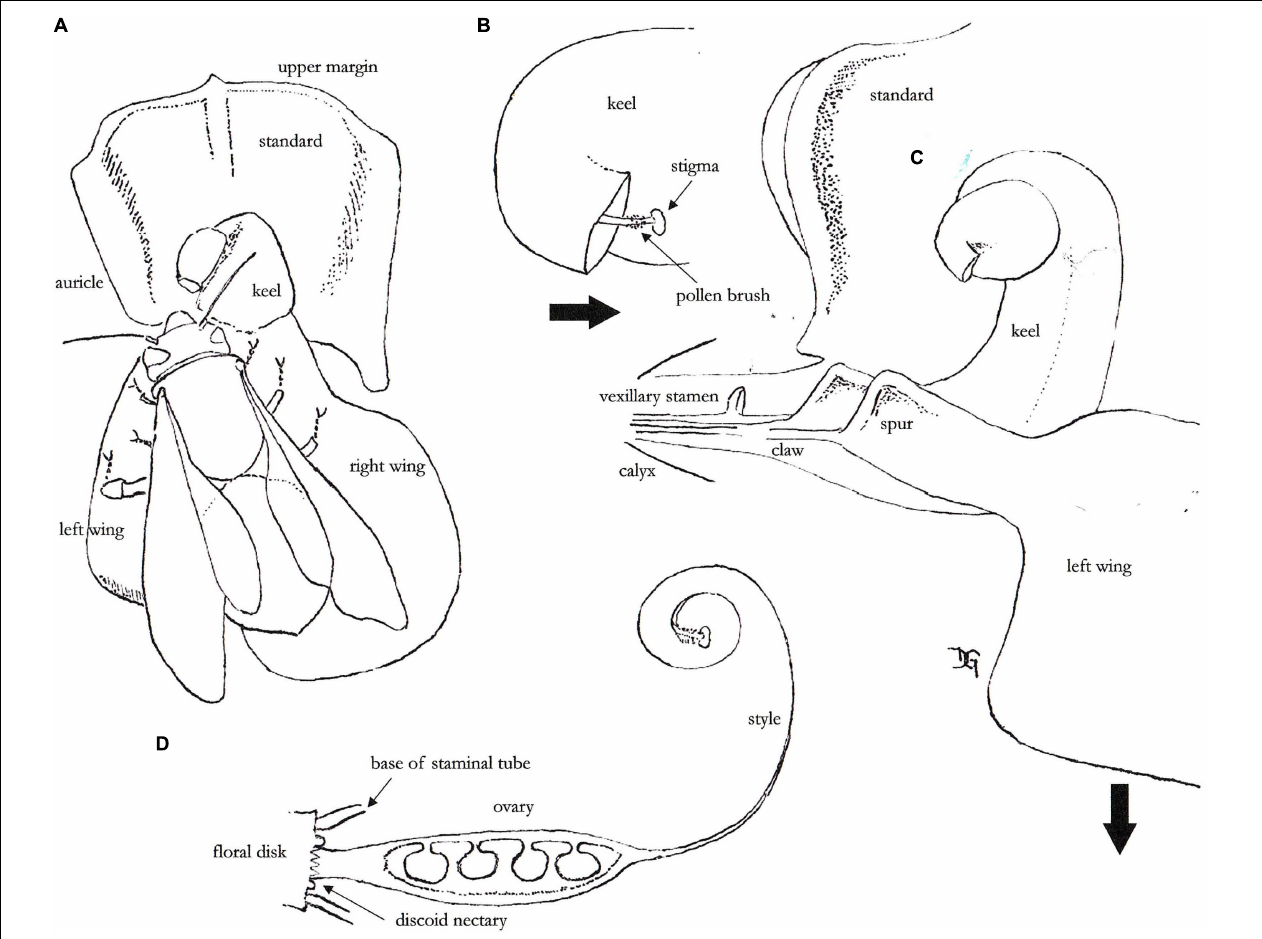
FIGURE 1 | The different parts of the flower in P. dumosus . (A) A bee has landed and located itself on the left wing. (B) Protrusion of the style end outside the cavity of the keel (direction indicated by the arrow). (C) The spur of the left wing has been slightly displaced to the right to show how it fits onto the lower part of the left petal of the keel (the arrow indicates the downward pressure exerted by the pollinator). (D) The denticulate discoid nectary between the base of the ovary and the staminal